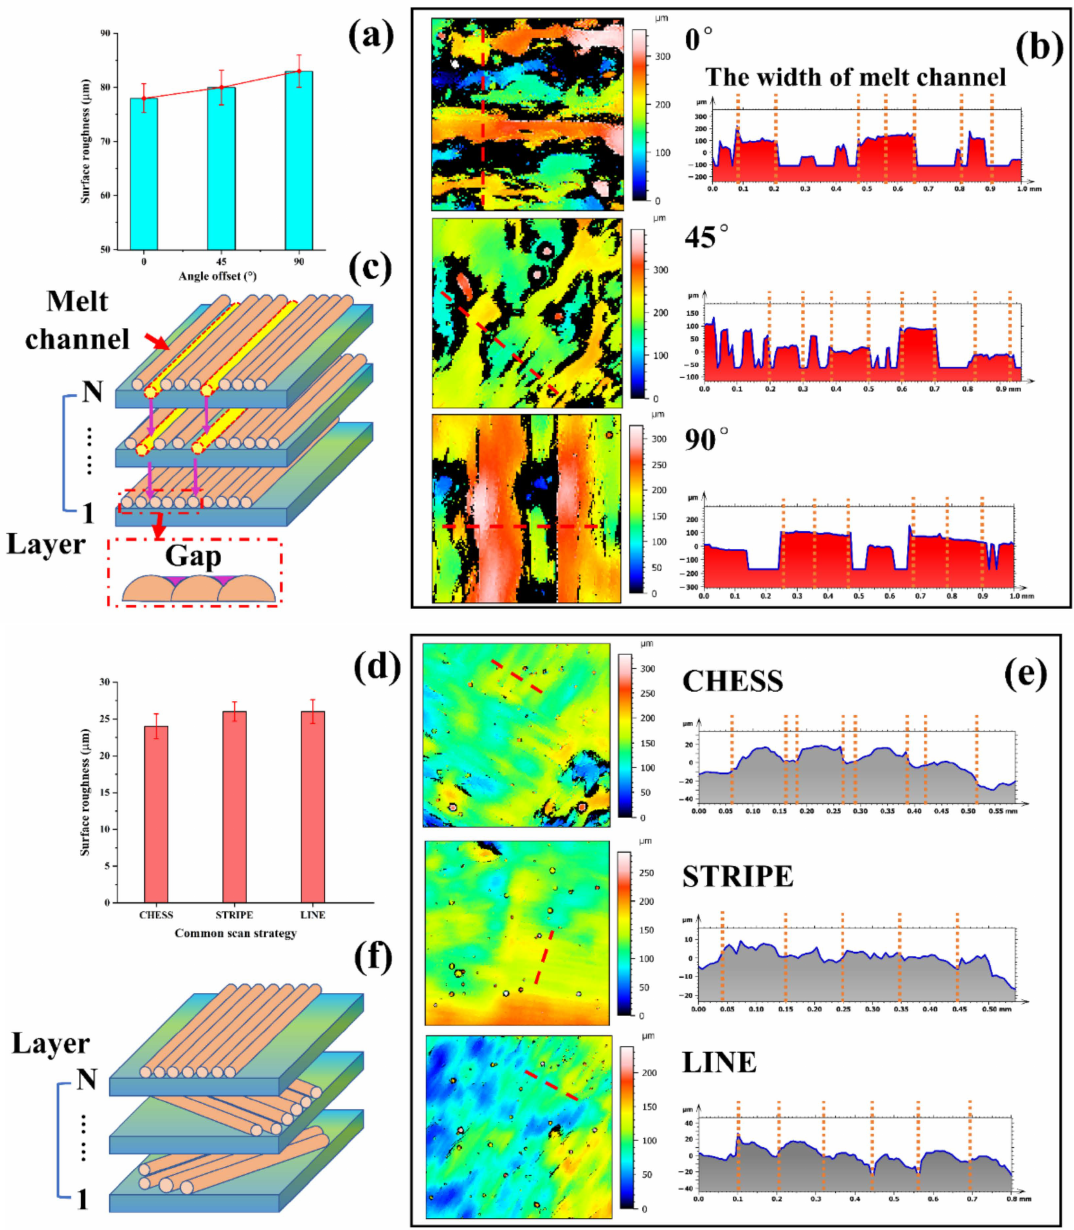
Figure 7. Surface roughness and corresponding cross-sections of L-PBF samples under a single scanning strategy. ( a ) Surface roughness of specimen at angular offset; ( b ) microscopic surface mor- phology and cross-sectional view of the sample under angular offset; ( c ) schematic diagram of sample surface collapse under angular offset; ( d ) surface roughness of specimen under general scanning strategy; ( e ) microscopic surface topography and cross-sectional view of the sample under the general scanning strategy; ( f ) schematic diagram of sample forming under general scanning